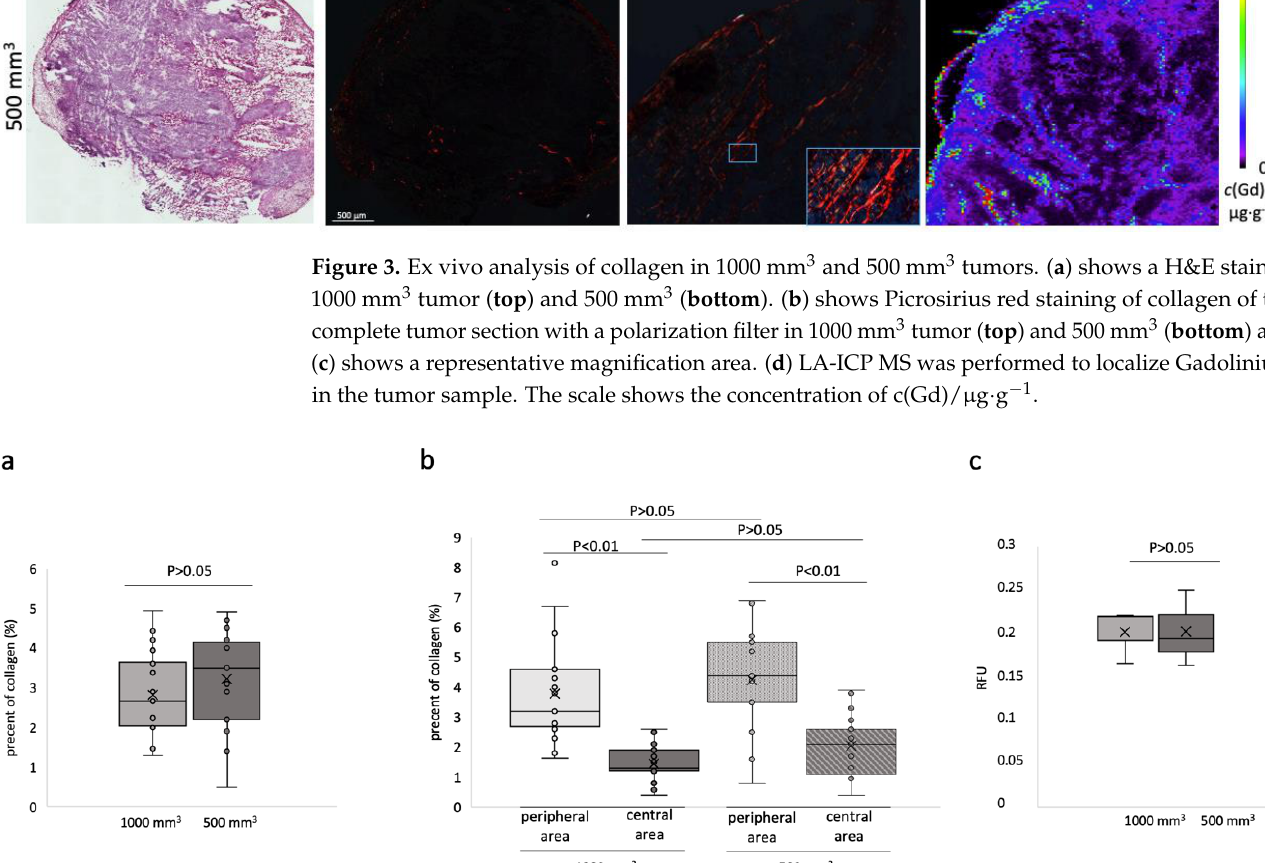
Figure 5. Correlation of the MRI data and the histological and elemental analysis. ( a ) The correlation between the percentage of stained collagen fibers by Picrosirius red (PSR) and the relative enhance- ments in MRI show a good correlation (y = −0 .068x + 1.1; R 2 = 0.74). ( b ) shows a correlation between the relative enhancement and the ICP-MS analyses for Gd. A good correlation is shown (y = 3.82x + 0.56; R 2 = 0.79). 2.3. Elemental Analysis of Tumor Tissue with Specific Regard to Gd LA-ICP-MS analysis was performed to localize Gd in the tumor tissue. For each tu- mor size, n = 3 mice were examined. The LA-ICP-MS data showed a good colocalization of the Gd with the histological data, as shown in Figure 3c. Gd could be detected in the peripheral area more than in the intra-tumoral space.